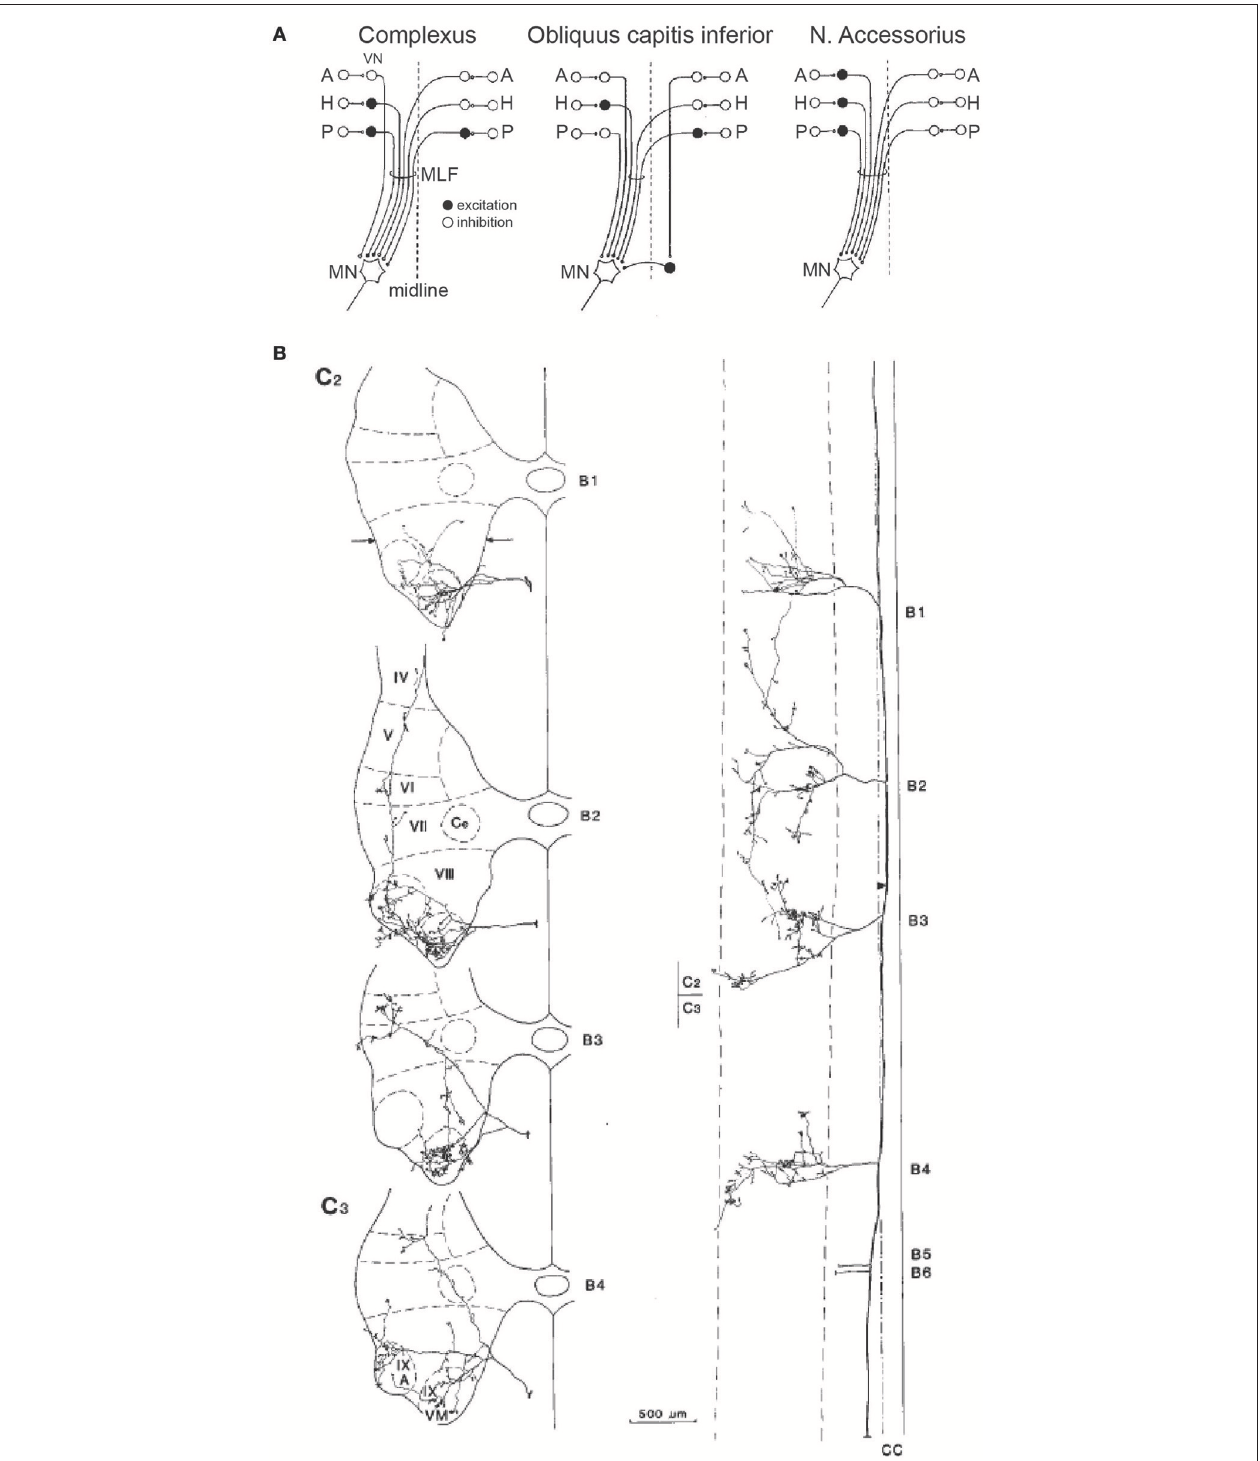
FIGURE 4 | (A) Convergent input patterns and pathways from the six semicircular canals onto motoneurons (MN) supplying three different neck muscles. Open and closed circles represent excitatory and inhibitory neurons, respectively. VN, vestibular nucleus; A, H, P, anterior, horizontal, and posterior canals; MLF, medial longitudinal fasiculus; N, nucleus. (B) Distribution of an uncrossed neuron in the MVST, showing projection patterns in the transverse (left) and horizontal (right) plane at the C2 and C3 levels. Note distribution of terminals throughout Rexed’s laminae IV–IX, and the ramifications across multiple levels of the cervical spinal cord. VM, ventromedial nucleus; A, accessory nucleus. Reproduced from Sugiuchi et al. (61), with permission from Elsevier.